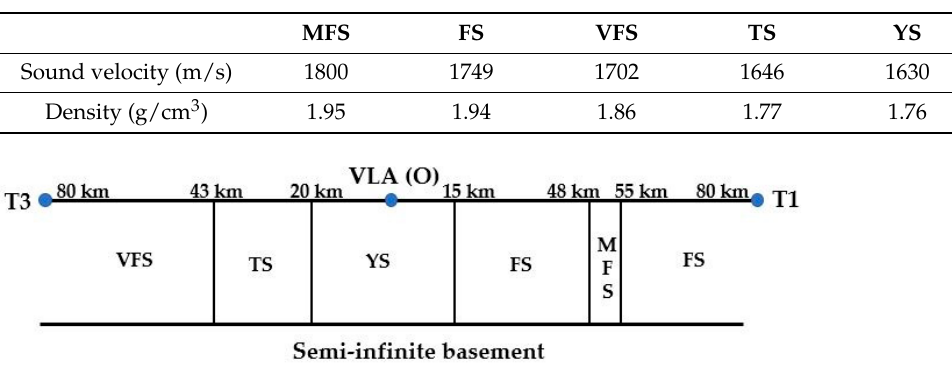
Table 1. Sedimentary parameters in experimental sea area.